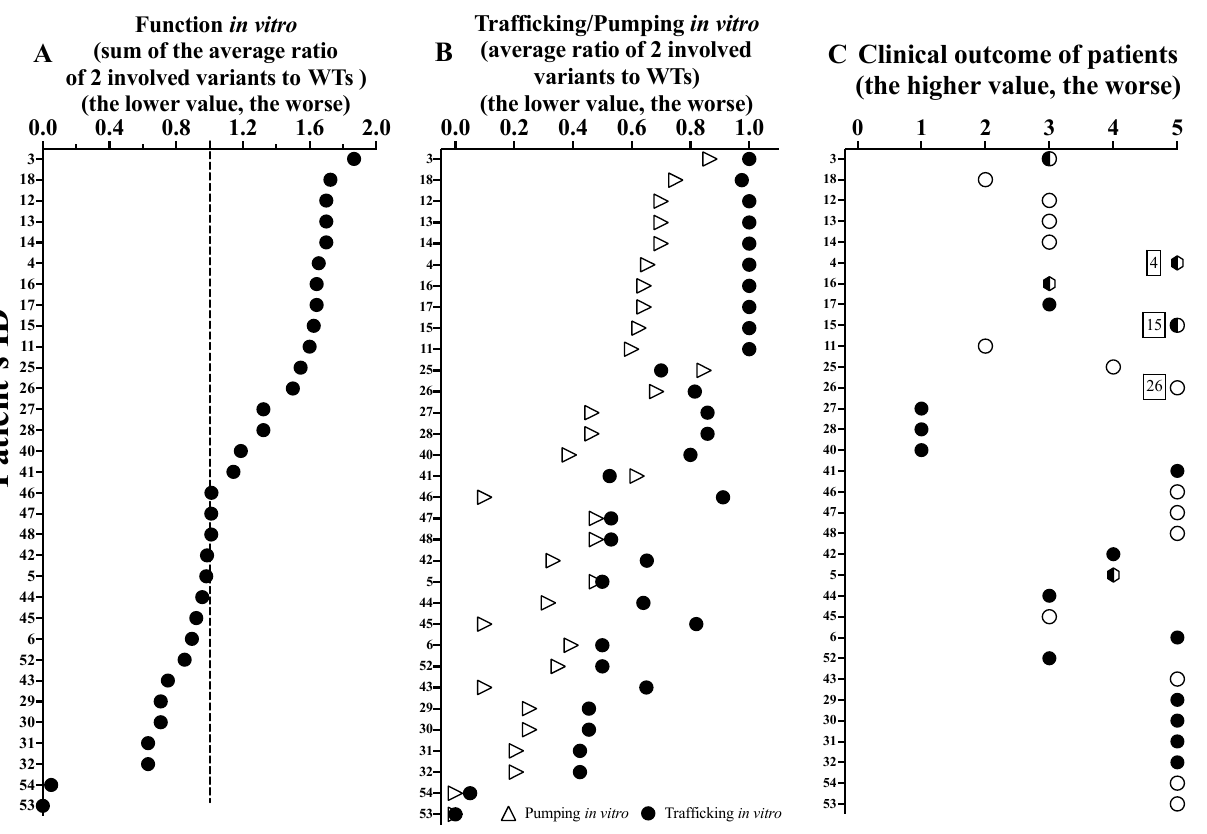
Figure 6. ( A ) Function in vitro of ABCA3 variants; ( B ) trafficking/pumping in vitro of ABCA3 variants; ( C ) clinical outcome of patients (32/54) with two variants that had been characterized in vitro, and sorting by sum function in vitro. The solid circles stand for the clinical outcomes of patients with compound heterozygous variants. The hollow circles stand for the clinical outcomes of patients with homozygous variants. The semi-hollow circles stand for the clinical outcomes of patients with homozygous variants and with lung transplantation. The semi-trapezoids stand for the clinical outcomes of patients with compound heterozygous variants and with lung transplantation. The function of the 2 variants (calculated as the sum of the average ratio of the 2 involved variants to the WTs) may correspond to the total functional activity of a subject with two alleles of ABCA3 . The dotted line at 1 (=50%) stands for normal trafficking and pumping sum, i.e., a function of 2. The values without compatible results are marked with patients’ ID 4, 15, and 26, respectively (Table S3). It was not possible to predict the clinical phenotype of the patient based exclusively on the ACMG classification of the ABCA3 variants (Figure S7A). The implementation of the results of the functional assays moderately improved the prediction (r = 0.69, Figure